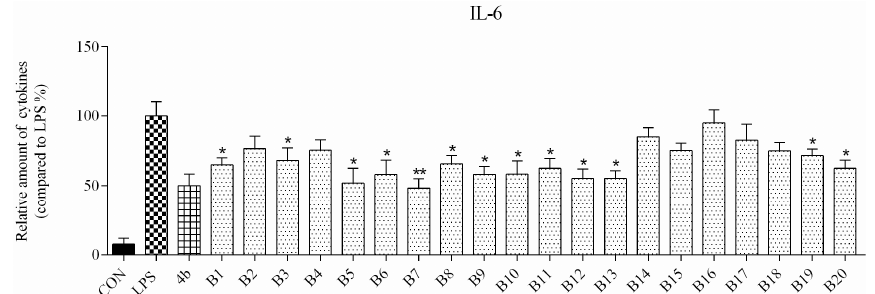
Figure 2. Relative levels of cytokine IL-6 in macrophages after treatment with compounds A1 – 6 and B1 – 20 at 10 μ M concentration as compared to LPS group and indomethacin group (*: p < 0.05; **: p < 0.01).